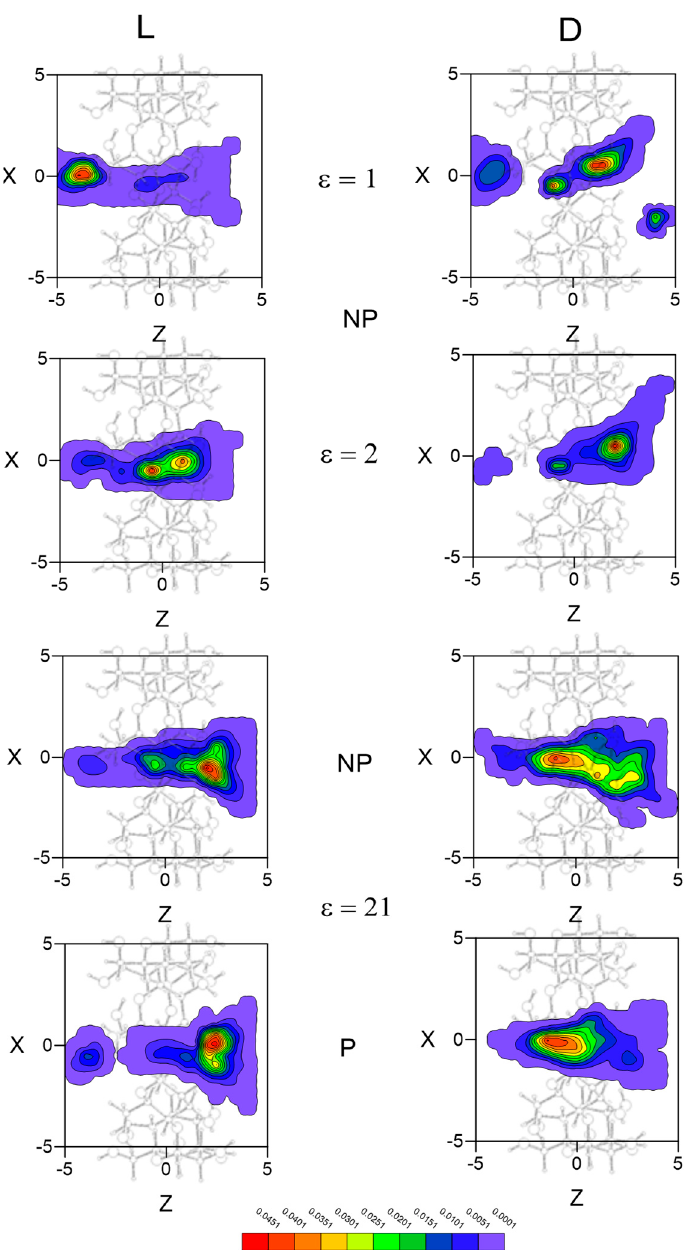
Figure 5. The projections in the XZ plane of the regions with greatest probability of presence for Ile in vacuo and with different solvents. A schematic projection of β –CD is included in this plane.